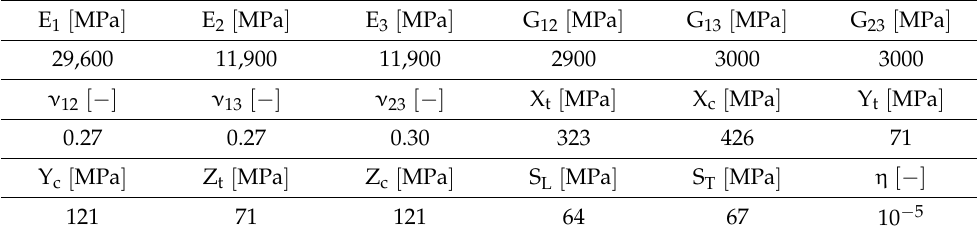
Table 1. Material properties for the pultruded GFRP material used in the CT tests.